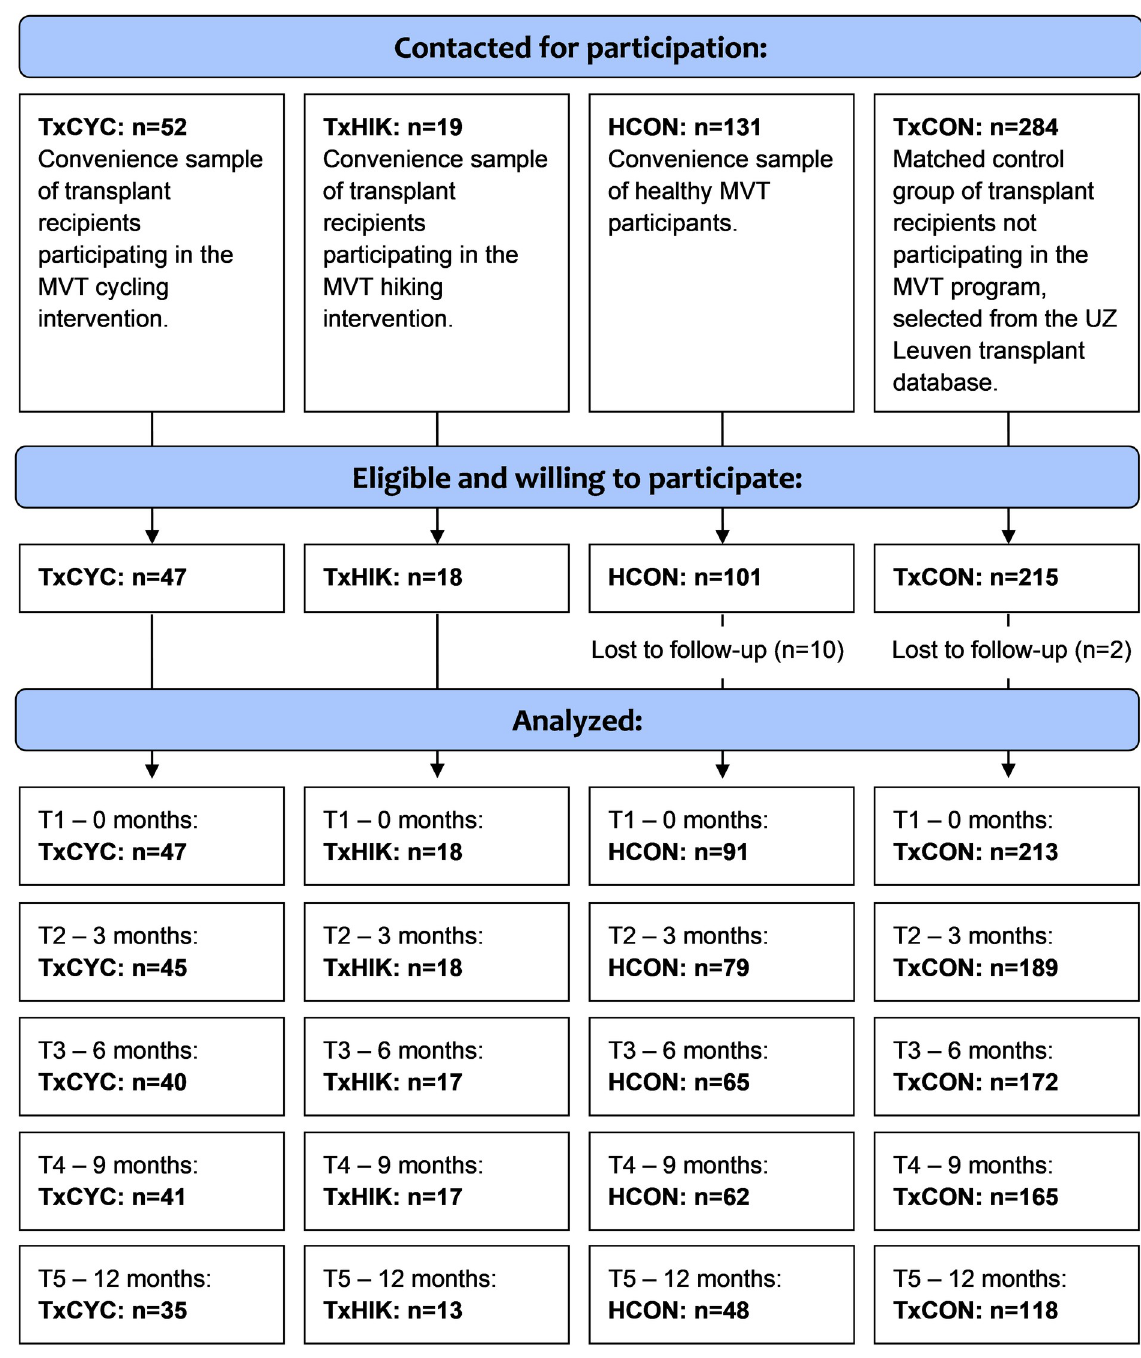
Fig 1. CONSORT flowchart adjusted for non-randomized trial design. All individuals who completed the survey at baseline (T1) were included in the present study. Study participants who did not to fill out one or more follow-up assessments were not excluded from the study, but were considered to have missed measurements for those time